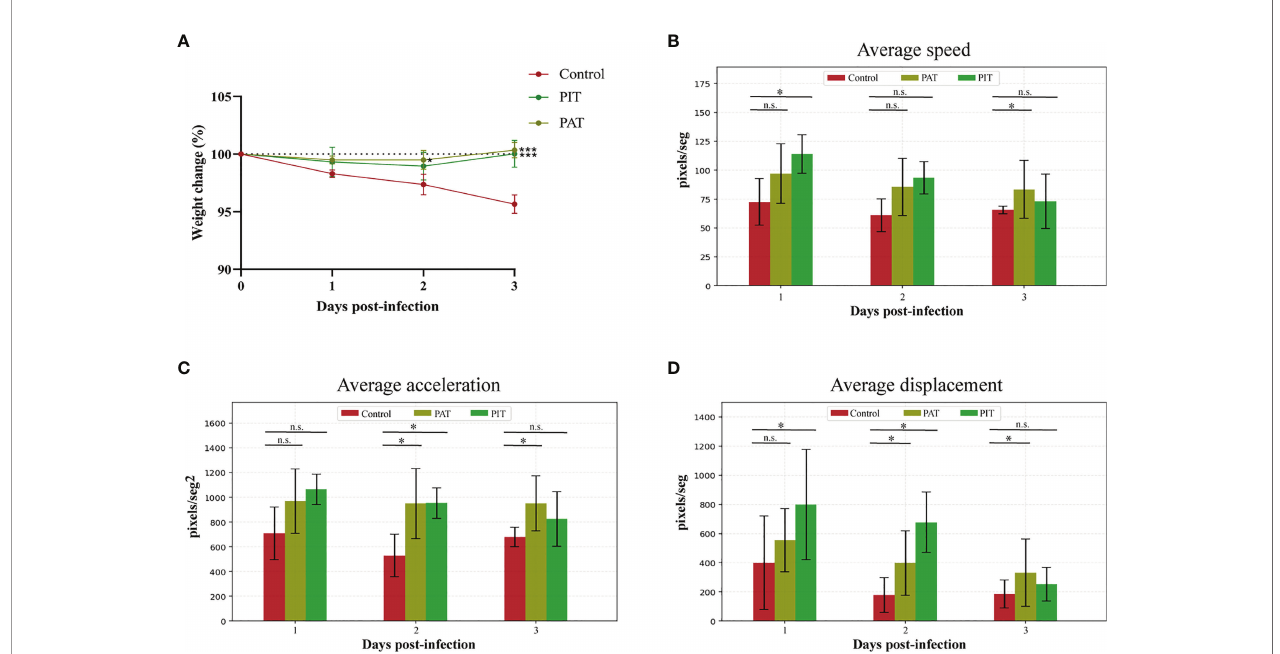
FIGURE 5 | Physical outcomes evaluation of hamsters infected with SARS-Cov-2 and intranasally administered with IgY-R. (A) Percentage variation of the weight of individuals over the experimental time-course. (B) Average speed variation (C) Average acceleration variation (D) Average displacement variation. DPI = Days Post Infection. Mean ± SD (error bars) is presented (n = 4 per group). The Mann-Whitney and Kruskal Wallis tests were performed to determine whether differences between Control and IgY-administered groups were signi fi cant (*) or non-signi fi cant (n.s.).